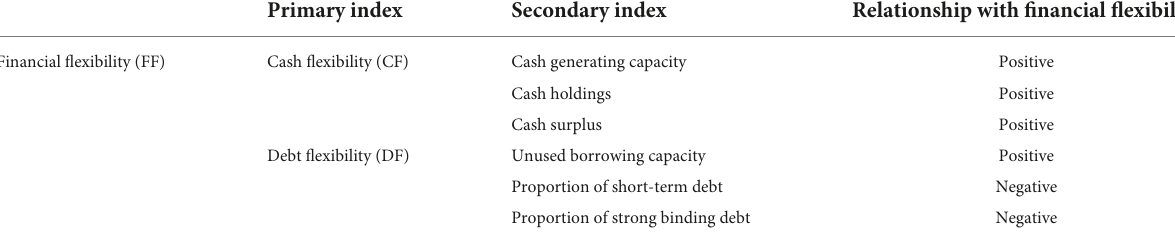
TABLE 1 Calculation index system of financial